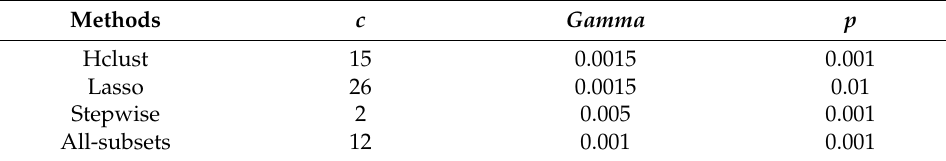
Table 7. Parameters of